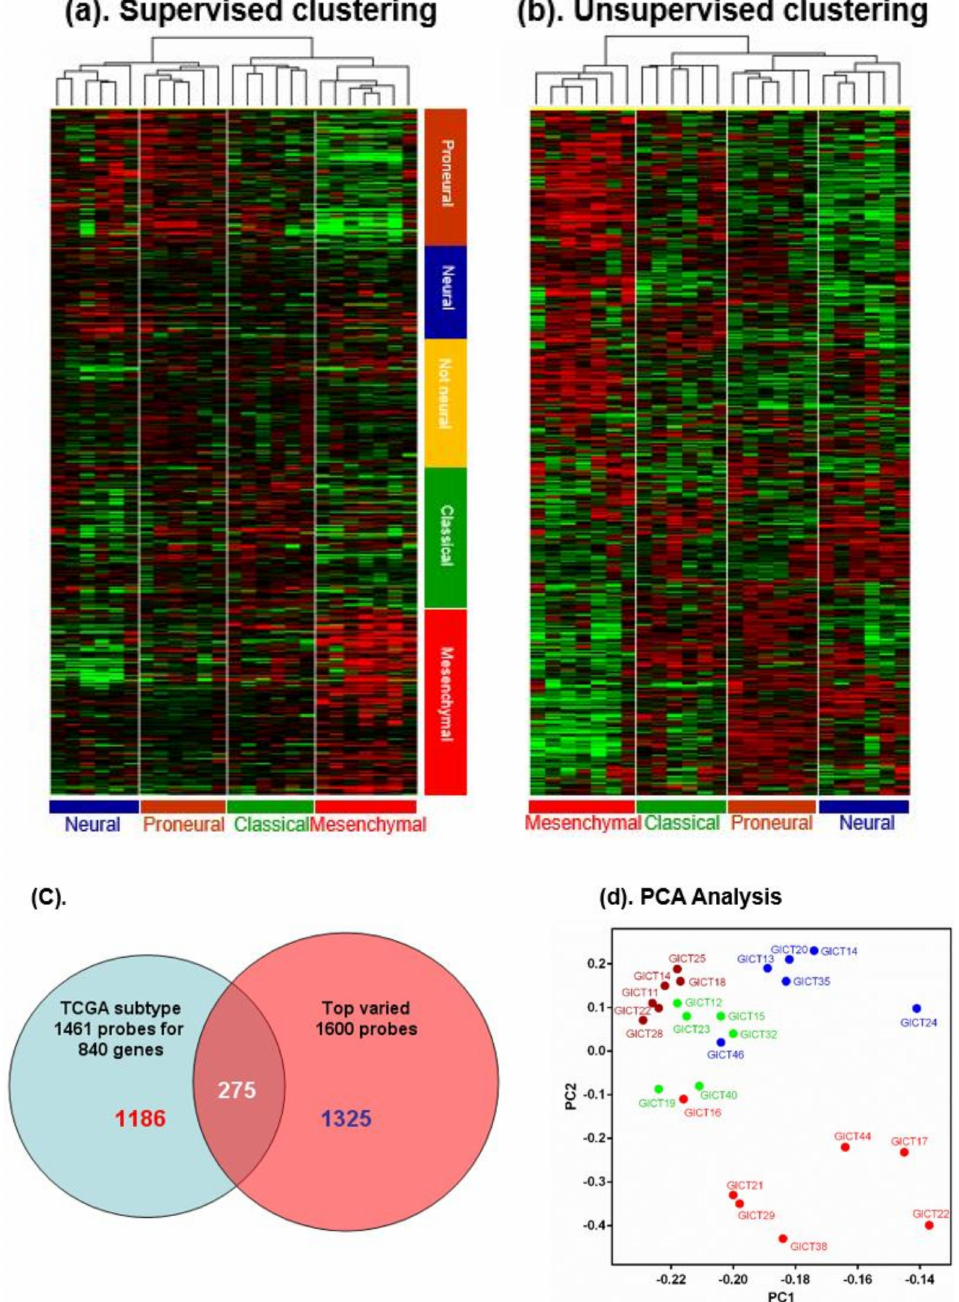
Figure 1. ( a , b ): Supervised clustering (The Cancer Genome Atlas (TCGA) 1461 probe sets) and unsupervised clustering (MTA 1600 probe sets) classified 25 glioma-initiating cell (GIC) cell lines